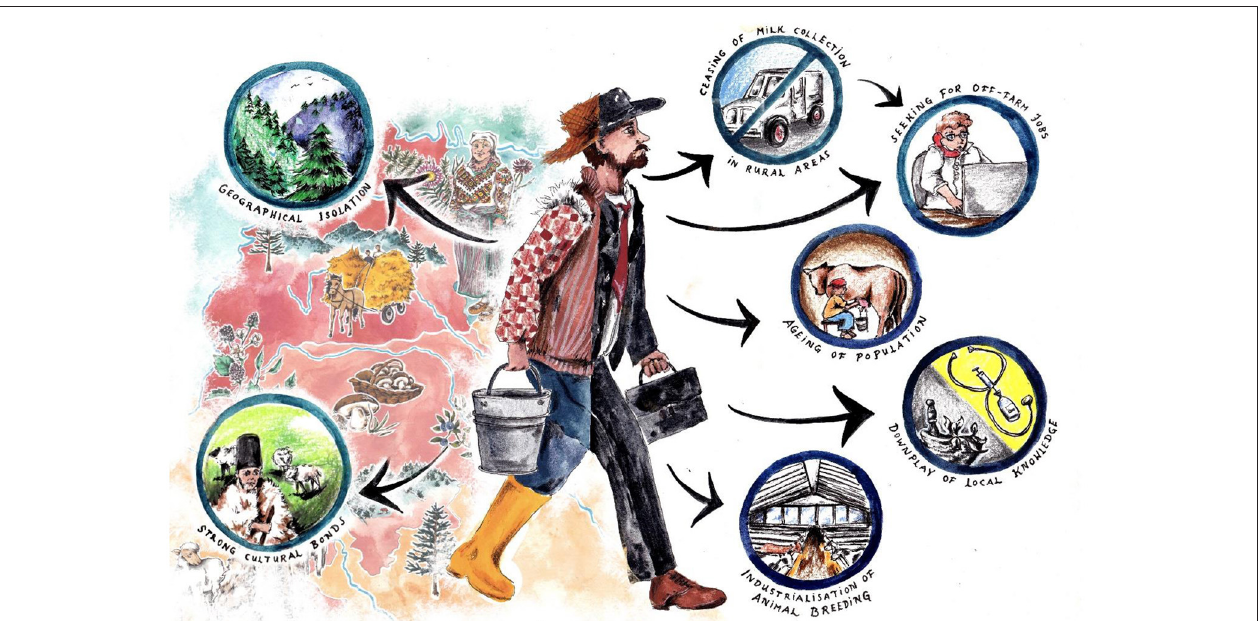
FIGURE 6 | Possible drivers of the persistence of ethnoveterinary knowledge in Bukovina (left) compared to possible drivers of ethnoveterinary knowledge erosion in Setomaa, Dzukija, and Karelia (Credits: Johanna